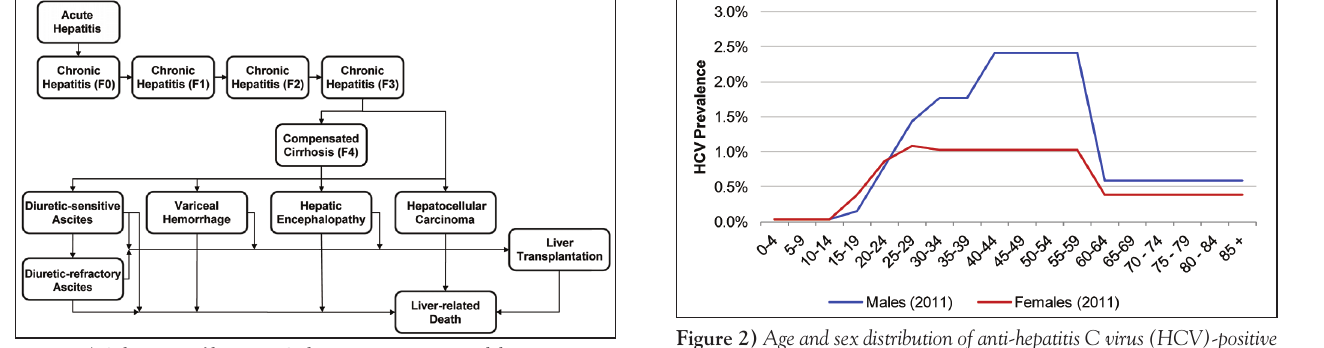
Figure 1) Schematic of hepatitis C disease progression model